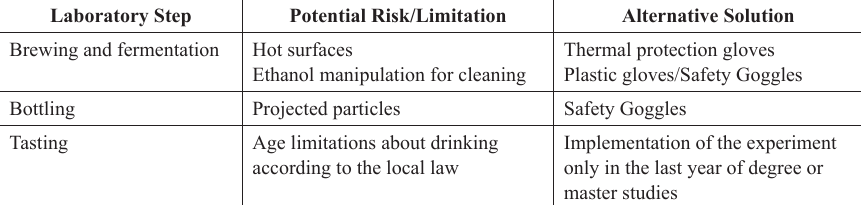
Table 4. Potential risks/limitations and alternative